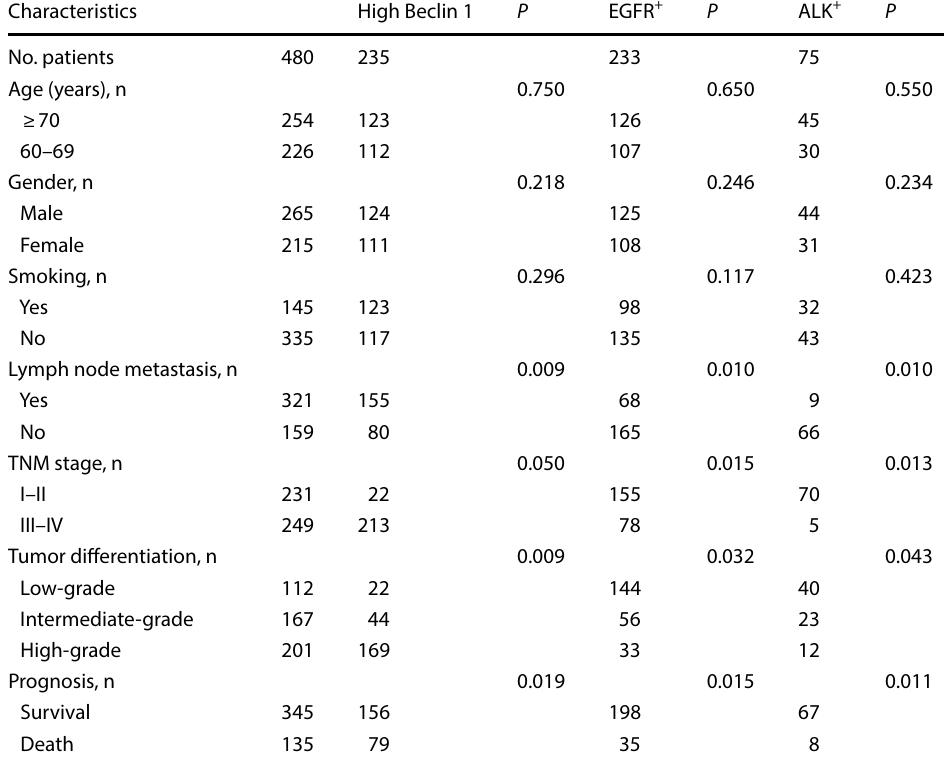
Fig. 1 Relative mRNA level of Beclin 1 in patients with and without non-squamous non-small cell lung cancer determined by